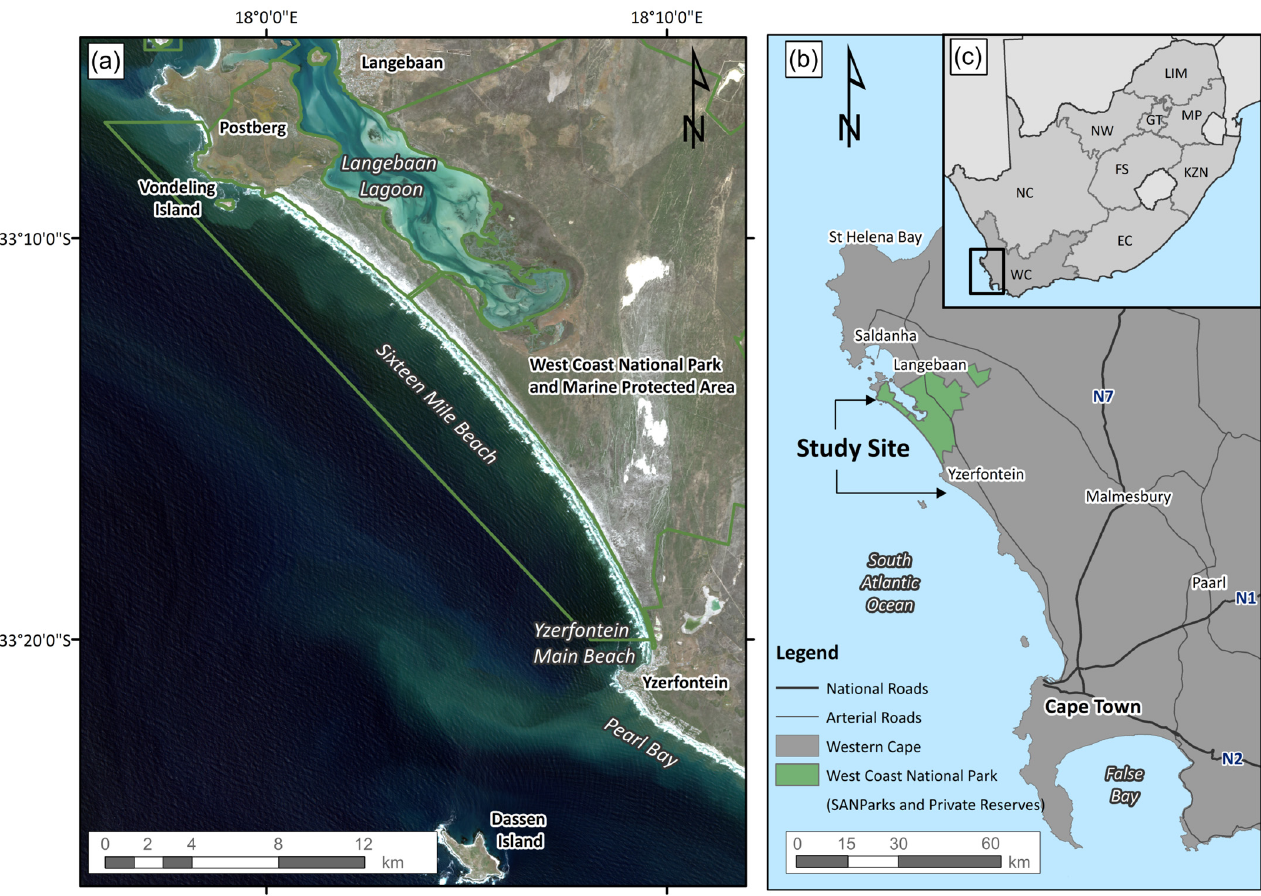
Figure 1. Overview of satellite imagery over the study area showing three coastal areas studied ( a ); Sixteen Mile Beach, Yzerfontein Main Beach and Pearl Bay ( b ); and the location of the study sites in the Western Cape Province of South Africa ( c ).